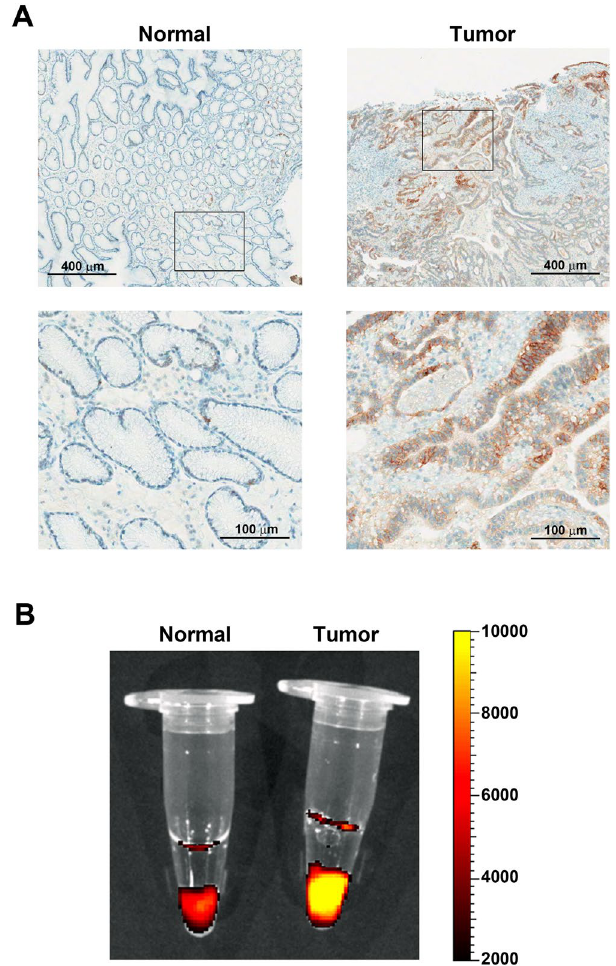
Figure 2. ( A ) Immunohistochemistry of normal-tumour paired gastric cancer tissue using anti-CD44v9 antibody. Normal tissue showed no CD44v9 signals in the section and has regularly arranged gastric ducts. In comparison, the CD44v9 signal is prevalent in tumour tissue and it has dysplastic phenotypes at the ductal regions. ( B ) Immunofluorescence stained images with tissue sample obtained from a gastric cancer patient using